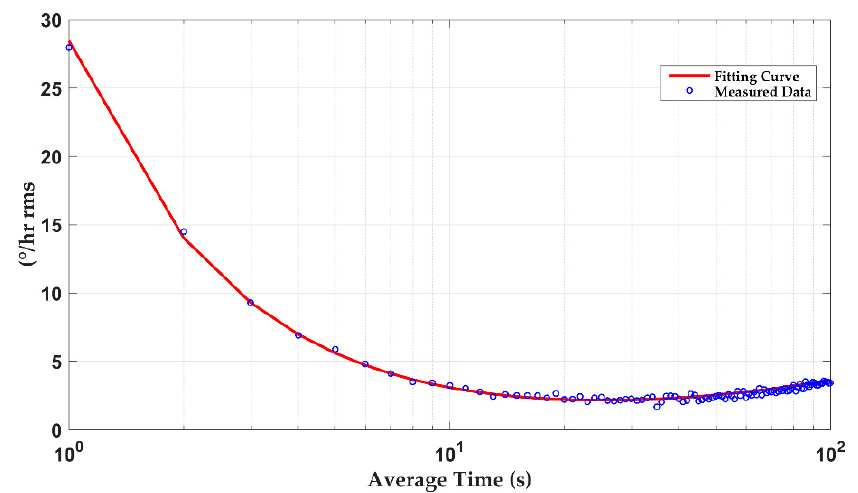
Figure 16. Standard Allen variance at 25 °C .